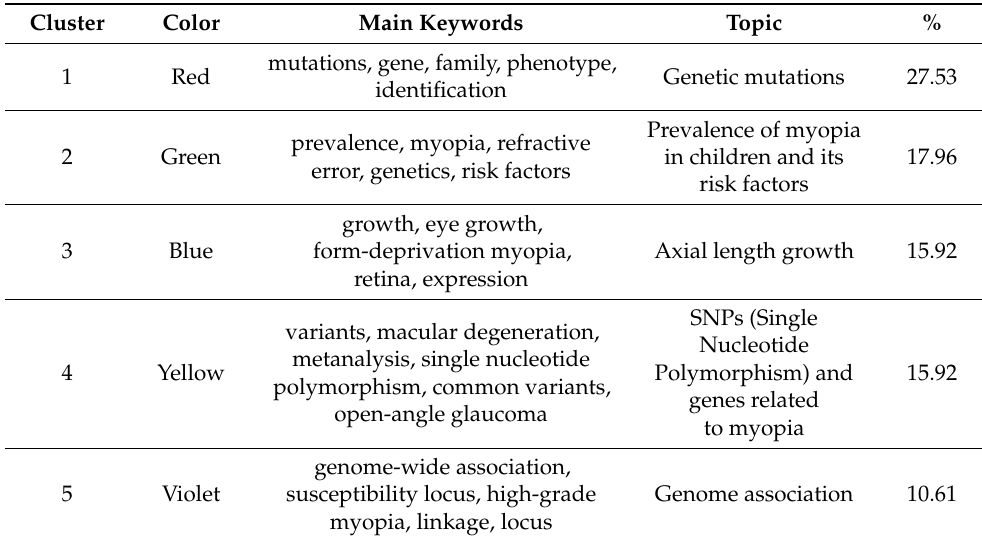
Table 7. Characteristics of the most used